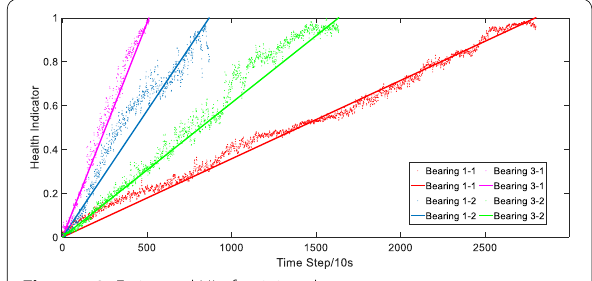
Figure 10 Estimated HI of training datasets